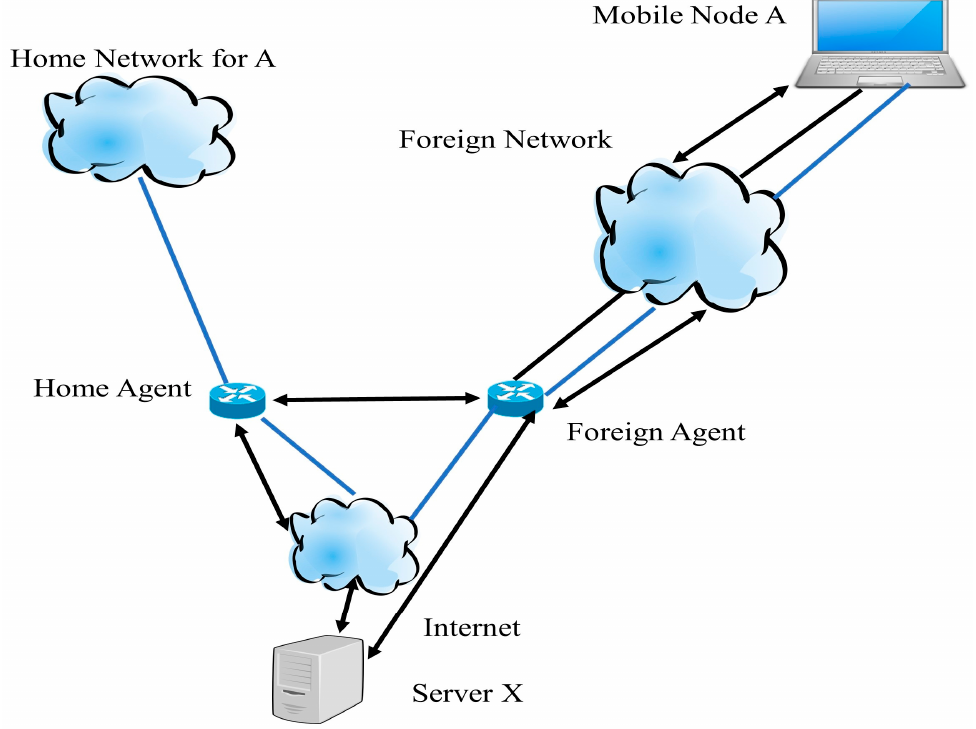
Figure 1. Operation of mobile